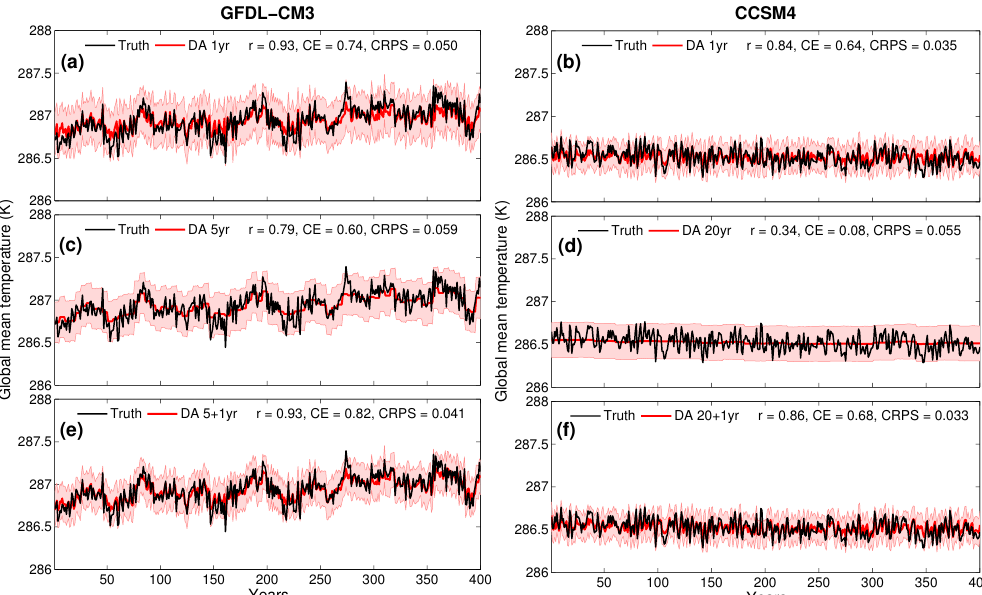
Figure 6. Global-mean temperature reconstructions (mean of 100 Monte Carlo iterations, with error bars indicating ± 2 σ of the iterations and analysis ensembles) for the three types of experiments discussed in the text and for each climate model simulation. Black lines indicate the true time series, while red lines indicate the reconstructed time series for only short-timescale (annual) pseudoproxies, only long timescale (5 or 20 years) pseudoproxies, and both long- and short-timescale pseudoproxies. Skill metrics of the reconstructions, correlation ( r ), coefficient of efficiency (CE), and mean continuous ranked probability score (CRPS) are shown at the top of each subpanel.